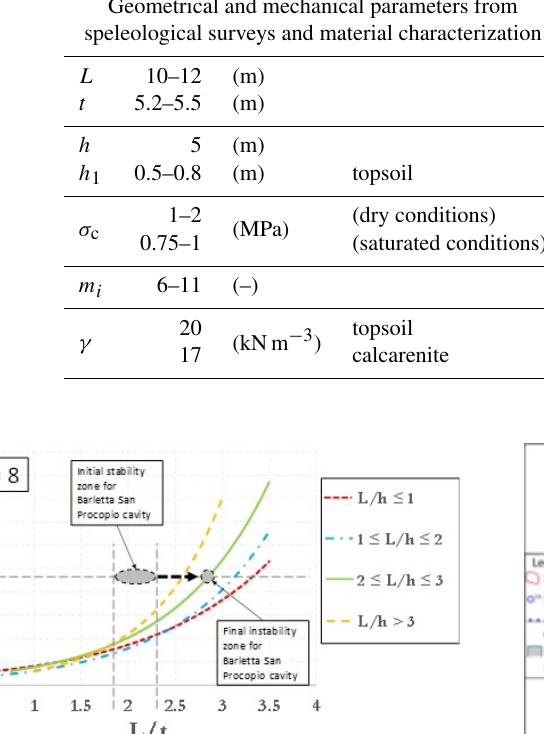
Table 2. Geometrical and mechanical parameters and adopted values for stability chart application to the Barletta underground quarry. Geometrical and mechanical parameters from Adopted values for stability chart